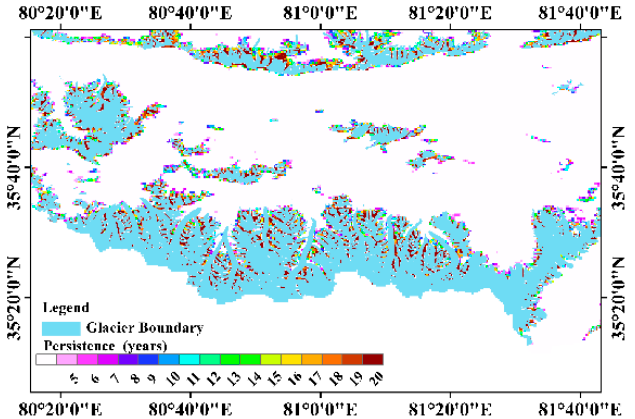
Figure 12. Example of the location of long-lasting snow in W Kunlun glaciers. The colored pixels refer to the years of persistence of long-lasting snow.